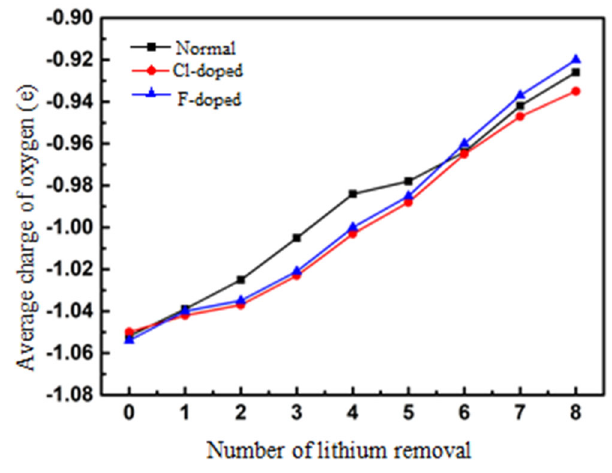
Figure 11. The variation of average valence state of oxygen during lithium removal.